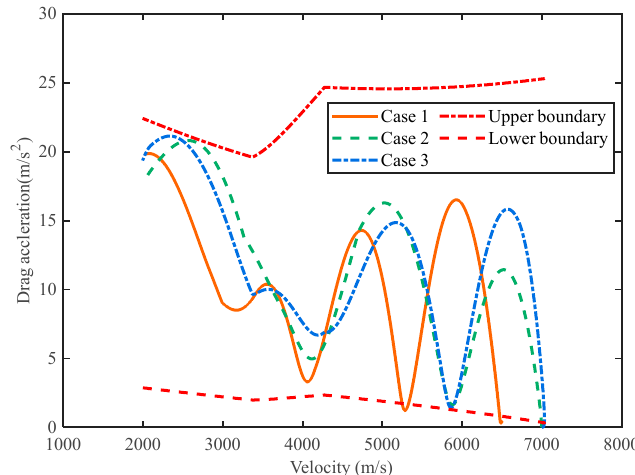
Figure 19. Resistance acceleration reentry corridor.